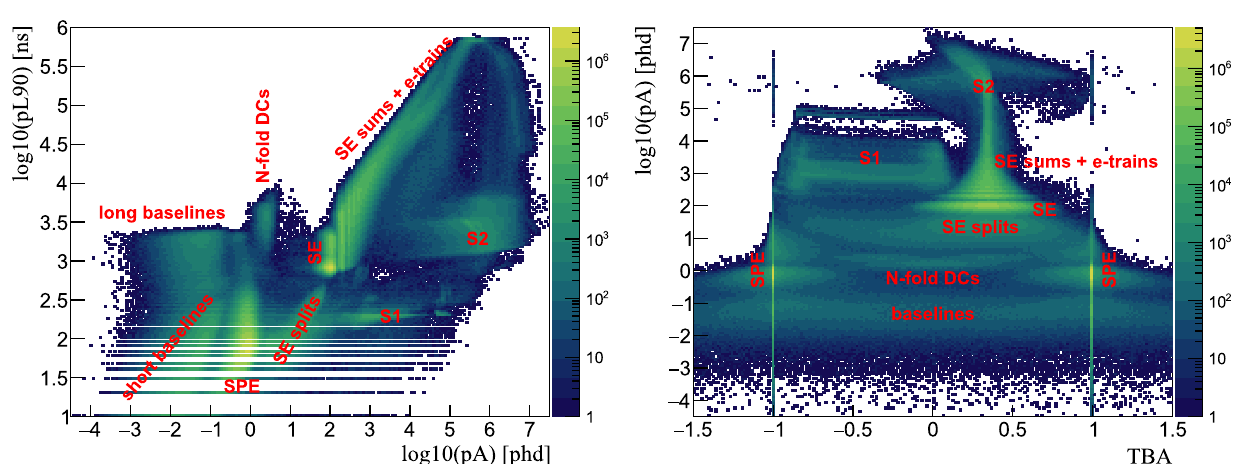
Fig. 2 Marginal distributions of the main pulse populations in pulse area( pA )vspulselengthat90%area( pL90 )space(left)andtop-bottom asymmetry ( TBA ) vs pA space (right). Not all isolated populations are labeled, only the cases presented in Fig. 1 have been highlighted. The